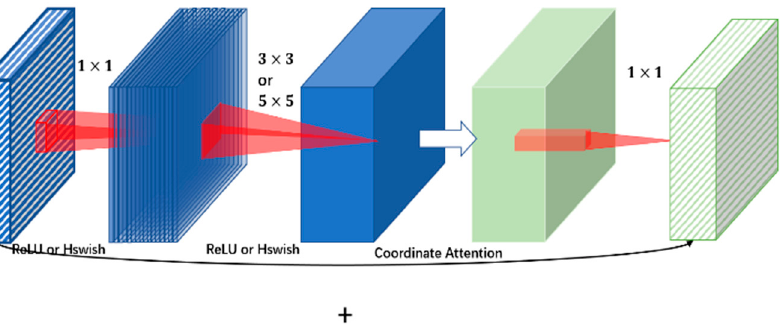
Figure 3. The design of our inverted residual module. Different colors represent input, hidden layer and output. Additionally, the change from blue to green represents the processing of the coordinate attention mechanism.